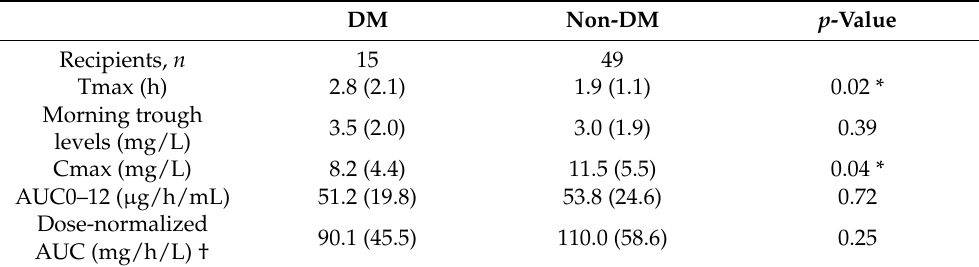
Values represent the mean (standard deviation) or n (%). Abbreviations: DM, patients with diabetes mellitus; non-DM, patients without diabetes; Tmax, time to maximum concentration; Cmax, maximum concentration; and AUC 0–12 , area under the concentration–time curve from 0 to 12 h. † Dose-normalized AUC values were normalized to 1000 mg of mycophenolate mofetil. * p < 0.05. MPA pharmacokinetics at 3 weeks and 3 months after transplantation is presented in Figure 1. At 3 weeks and 3 months after transplantation, the Cmax of MPA tended to be lower in the DM group than in the non-DM group, whereas the Tmax of MPA was significantly longer in the DM group (* p < 0.05). However, the MPA blood concentration tended to be higher in the DM group after 6 h of administration, whereas the AUC 0–12 was equivalent between the groups.